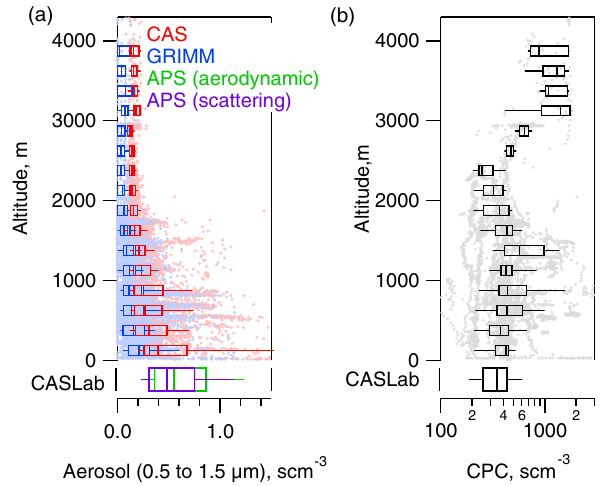
Figure 9. Aircraft clear sky aerosol concentrations (scm − 3 ) alti- tude profiles. Data are from (a) CAS and GRIMM instruments. Sur- face concentrations from CASLab are shown for comparison, from the APS; green – aerodynamic particle size concentrations; purple – scattering cross-section-derived particle size concentration mea- surements; (b) total fine aerosol concentration profiles, from CPCs on the aircraft and at the CASLab ( D >